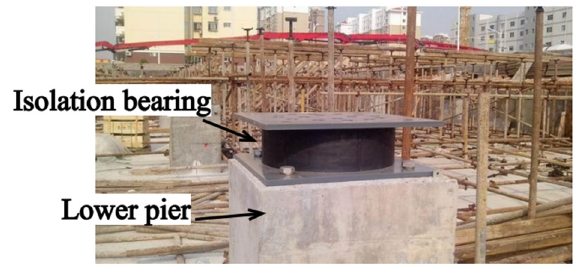
Figure 6. Construction and installation of isolation bearing.